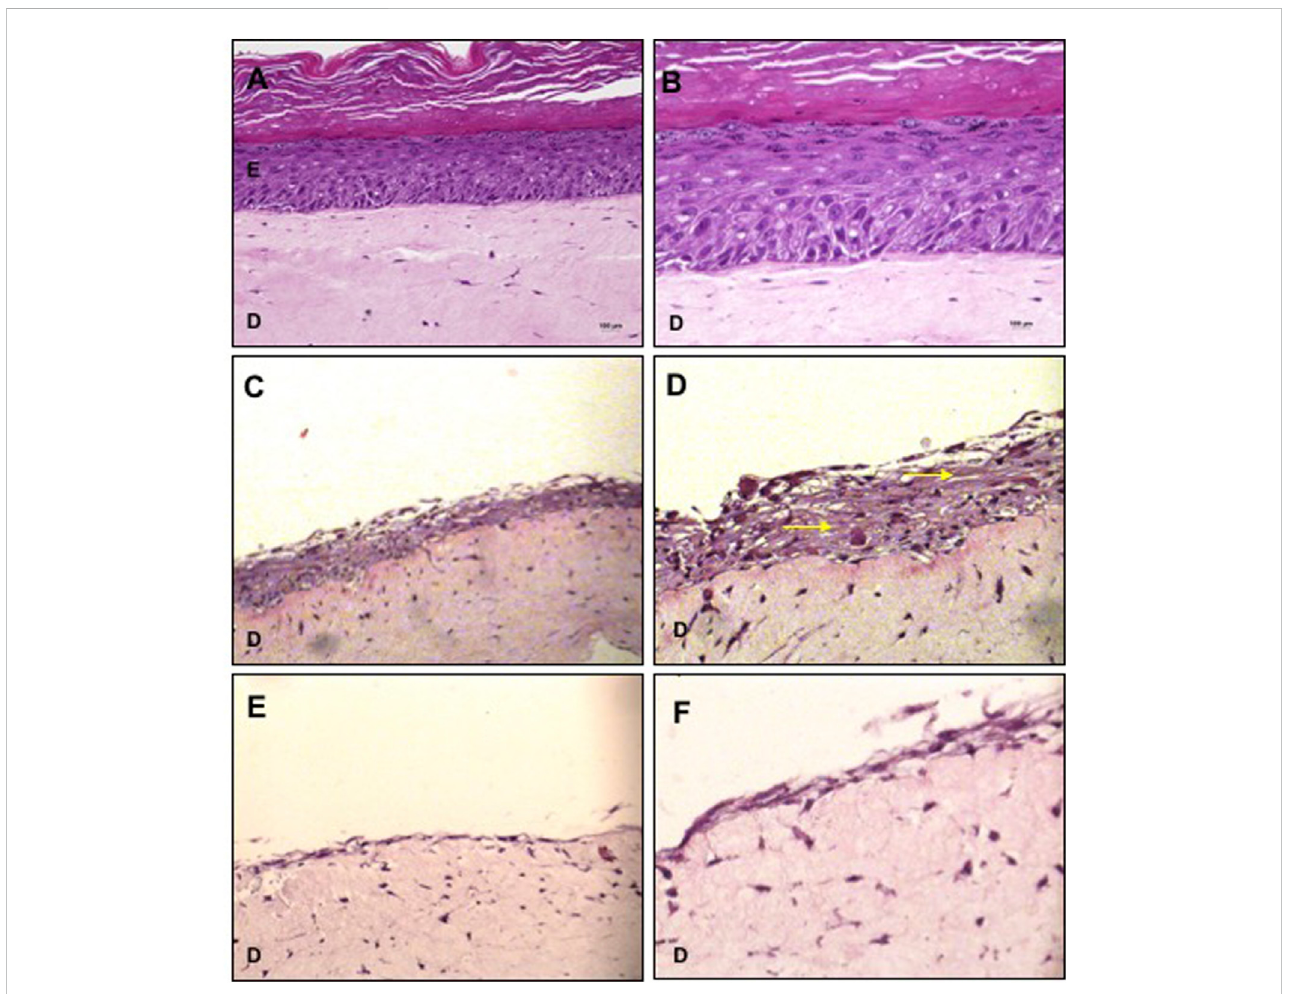
FIGURE 1 Organotypicculturesusingcollagenwith fi broblastsasdermalequivalent. (A,B) BasalkeratinocytesculturedwithKGM/DMwereusedaspositivecontrol for the strati fi ed epidermis. (C,D) MSC cultured with KGM/DM or with (E,F) LD10 medium. After 1 day of immersion in the indicated medium in each case, cultureswereexposedtoALIfor10 daysintheDM (A,D) orLD10medium (E,F) .Hematoxylin-eosinstaining.Magni fi cationof200x (A,C,andE) and400x (B,D, and F) . Yellow arrows: extracellular matrix/intercellular substance. Scale bar: 100